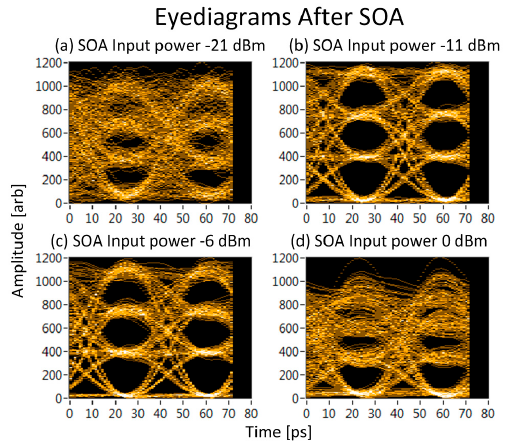
Figure 7. We display eyediagrams derived from the output intensity waveforms from the SOA. The eyediagrams are taken over a wide range of input power levels to the SOA in order to display different signal impairments. ( a ) − 21 dBm; in this power regime the ASE noise dominates, note the larger splitting of the upper stronger PAM4 symbols due to signal-spontaneous beat noise; 20,000 symbols used in the simulation. In this power regime, the signal is strong enough to overcome the ASE noise added by the SOA while being weak enough to not induce nonlinear gain saturation; enough to begin inducing distortions by saturating the gain of the amplifier; ( d ) 0 dBm; in this power regime, the clearly visible signal distortions are due to strong gain saturation within the